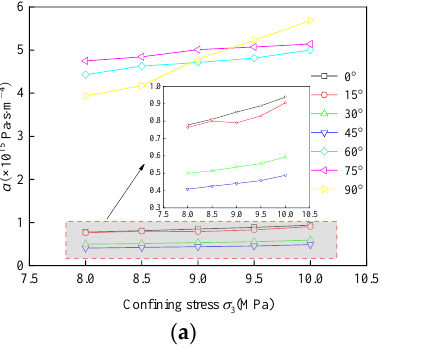
Figure 7. Fitting relationship between − ∇ P and Q of multi ‐ fracture sandstone samples under different confining pressures: ( a ) SF45; ( b ) ST45; ( c ) SY45. Figure 8 shows the variation of linear term coefficient a and nonlinear term coefficient b of the Forchheimer equation. a gradually increases with increased σ 3 in the sandstone samples with single, T ‐ shaped, and Y ‐ shaped fractures, caused by the closure of internal fractures under the confining pressure; b decreases gradually with the increased σ 3 . When σ 3 of samples SF0-SF90 increases from 8 to 10 MPa, the values of a and b change significantly with increased fracture inclination α . The a value at 0, 15, 30, and 45 ◦ is smaller than that at 60, 75, and 90 ◦ . When α is 0 ◦ , 15 ◦ , 30 ◦ , and 45 ◦ , the b value is greater than that when α is 60, 75, and 90 ◦ . In the process of samples ST0-ST90 and samples SY0-SY90, when σ 3 increases from 8 to 10 MPa, the a and b value changes are relatively small with increased fracture inclinations.